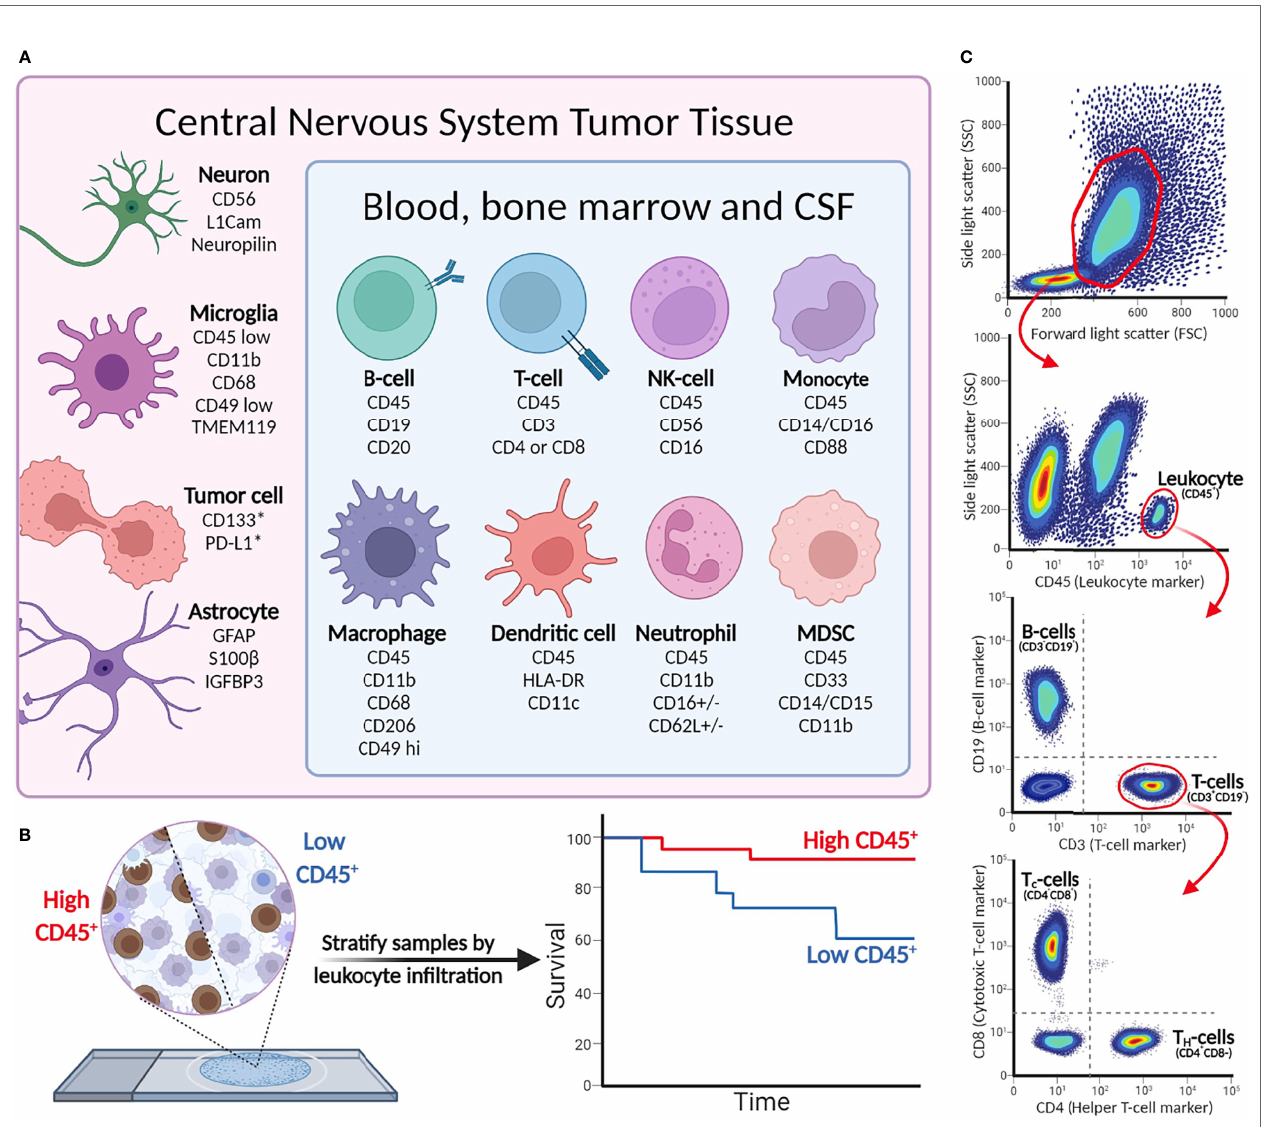
FIGURE 2 | (A) Cell-type markers for identi fi cation of immunological, tumor, and stromal cells in CNS malignancies. (B) Immunohistochemistry detects leukocytes in tumor tissue, and can be used to stratify patient tumor tissue (as demonstrated in Murata et al.). *Cell surface expression may vary between tumor cells and indications. (C) Example of fl ow cytometry gating strategy. More elaborate fl ow panels can be used for in-depth phenotyping of immune cells, providing information on speci fi c cell subsets and status